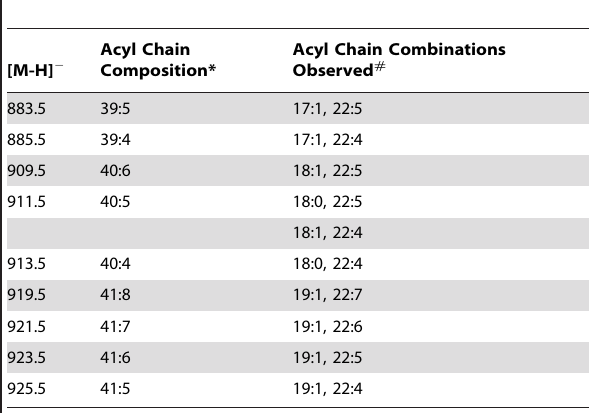
Table 1. Phosphatidylinositol species identified in A. pallida lipid extracts.